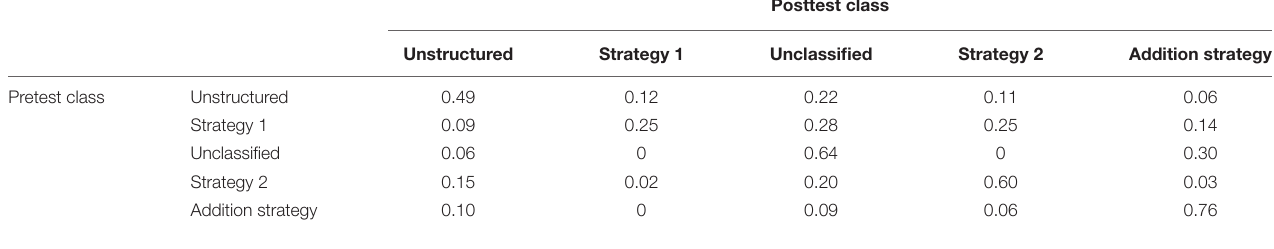
TABLE 5 | Transition probabilities for classes from pretest to posttest.